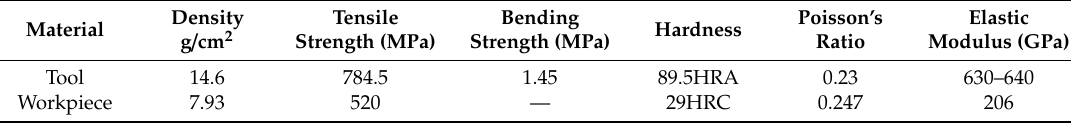
Table 2. Tool and workpiece material performance